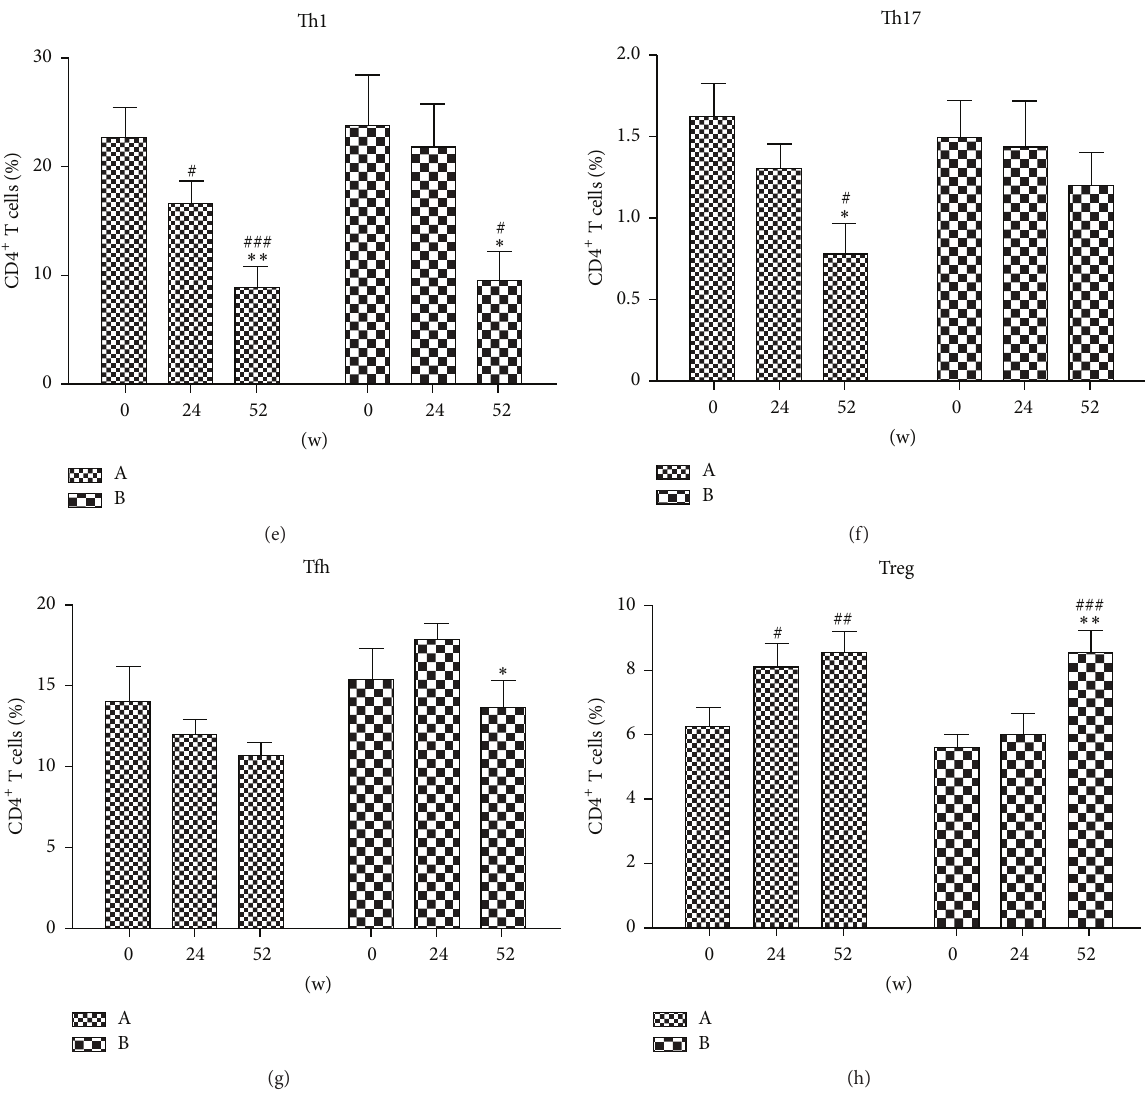
Figure 2: Frequencies of CD4 + T cell subset in RA patients before and after therapy. The proportion of IFN- 𝛾 + Th1, IL-17 + Th17, circulating CD4 + CCR 7 low PD- 1 high Tfh, and CD4 + CD25 + Foxp3 + Treg in CD4 + T cells was analyzed by flow cytometry on 0 w, 24 w, and 52 w. (a) Representative staining data showing the proportion of Th1. (b) Representative staining data showing the proportion of Th17. (c) Representative staining data showing the proportion of Tfh. (d) Representative staining data showing the proportion of Treg. (e) Collated data showing the proportion of Th1. (f) Collated data showing the proportion of Th17. (g) Collated data showing the proportion of Tfh. (h) CollateddatashowingtheproportionofTreg. ∗ 𝑝 < 0.05 , ∗∗ 𝑝 < 0.01 ,and ∗∗∗ 𝑝 < 0.001 arestatisticallysignificantcomparedto24 w. # 𝑝 < 0.05 , ## 𝑝 < 0.01 , and ### 𝑝 < 0.001 are statistically significant compared to 0w. Group A: iguratimod was administered to patients for 52 weeks.